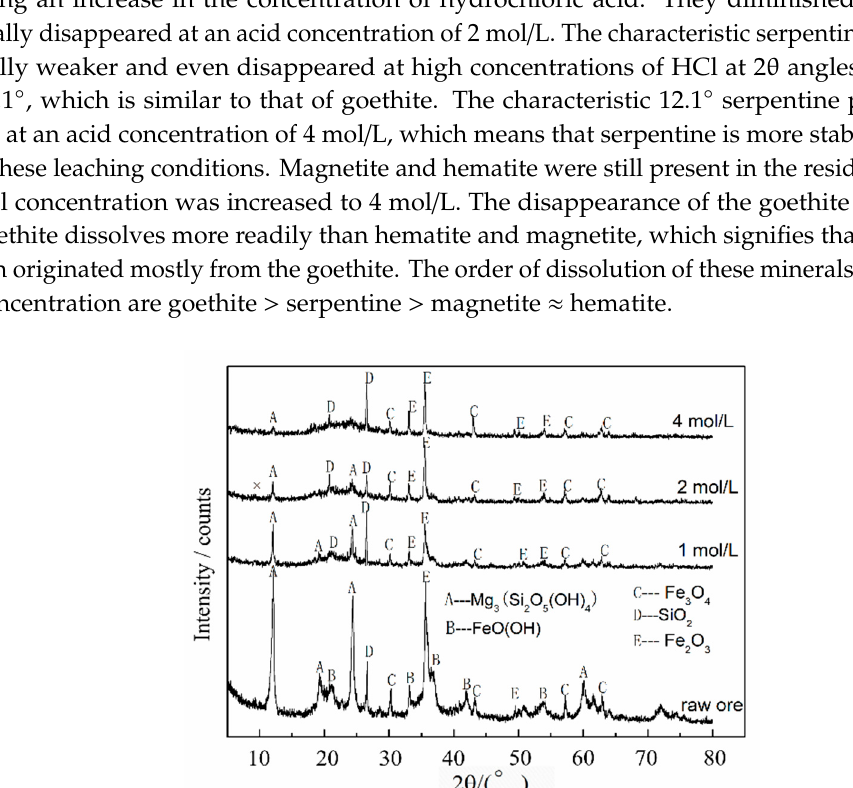
Figure 2. XRD diagram of leaching residues at different acid concentration.